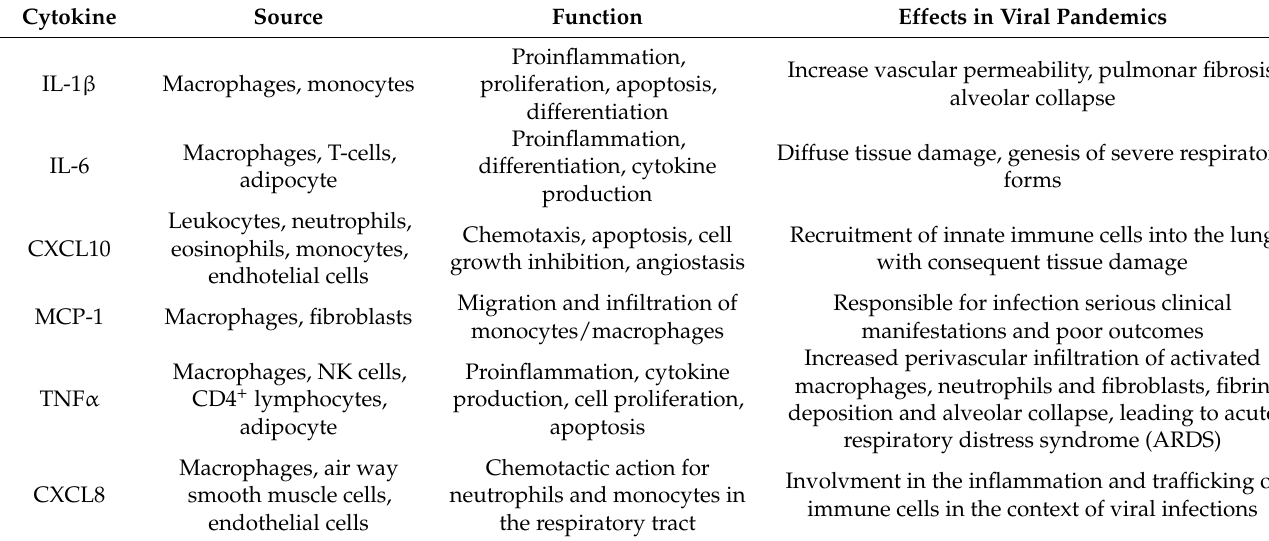
Table 1. Involvement of main cytokines in viral